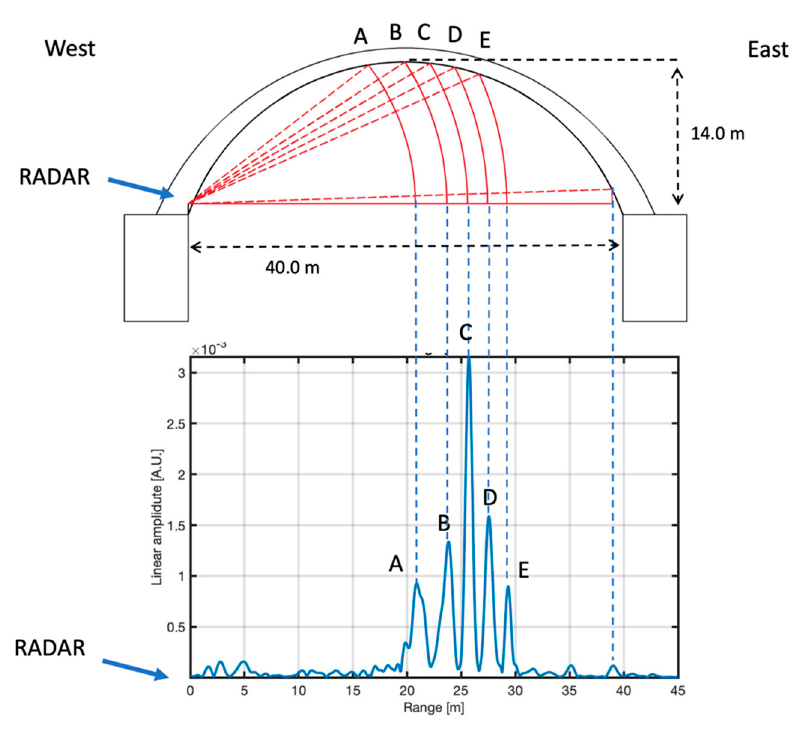
Figure 9. Radar plot in range as acquired at the Kaflan-Kuh Bridge.